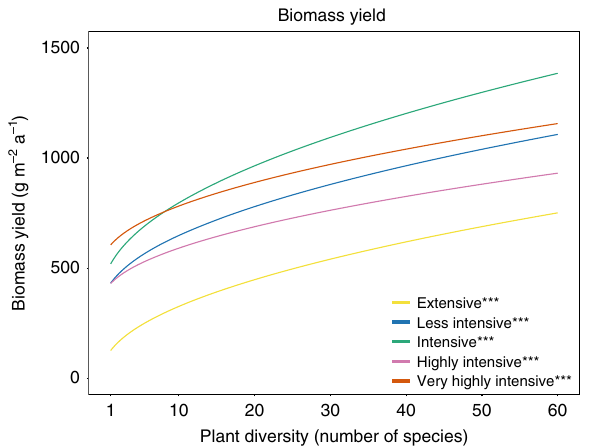
Fig. 4 Predicted annual biomass yield as a function of plant diversity and management intensity. *, **, *** denote signi fi cance at the 5%, 1%, and 0.1% level of the plant diversity effect per management intensity, respectively. The signi fi cance levels are based on a mixed effect model, see Eq. (4). The corresponding coef fi cients for the plant diversity effect per management intensity can be found in Supplementary Table 6. Source data are provided as a Source Data fi